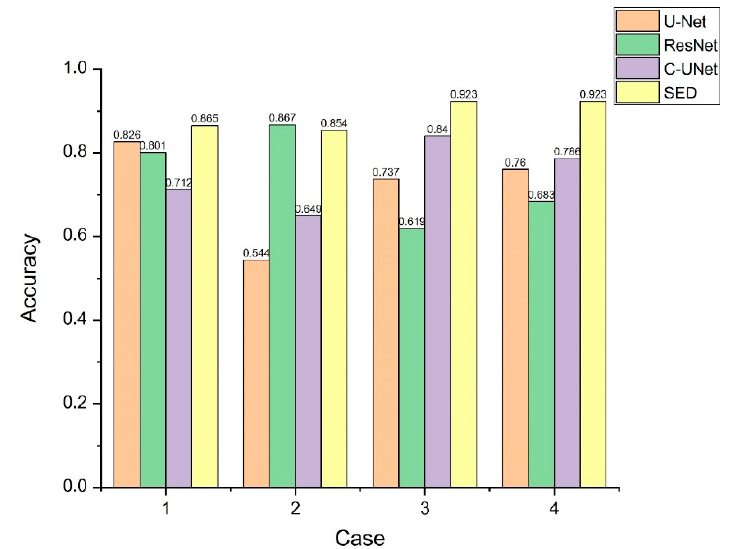
Figure 8. Accuracy value comparison from four cases by U-Net, ResNet, C-UNet, and the proposed SED.